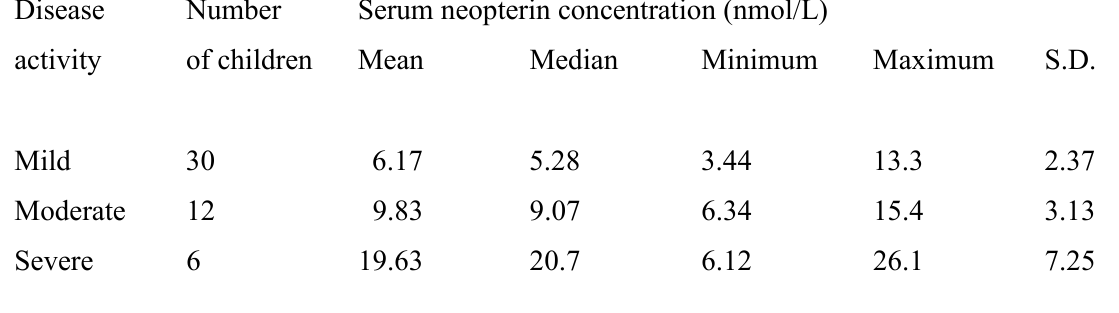
Table 1. Serum neopterin concentration in different disease activity (according to Truelove-Witts score) in chil- dren with ulcerative colitis